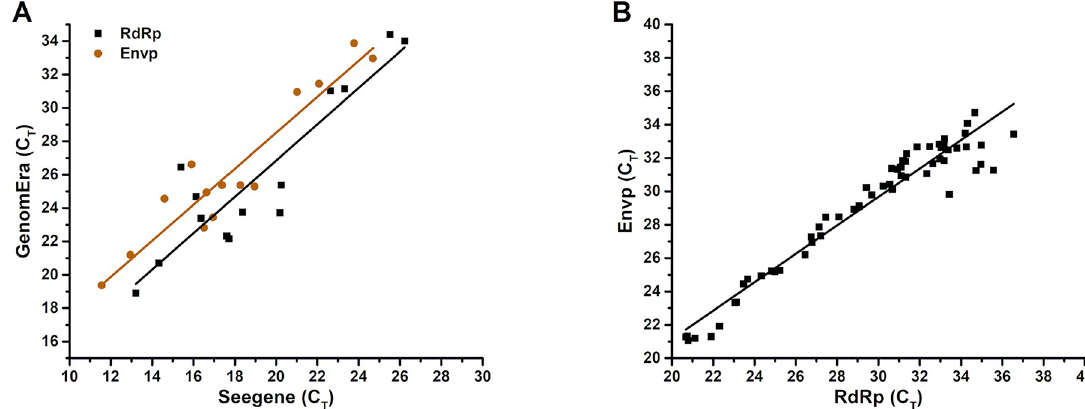
Fig 1. Linear correlations between the C T values obtained using Seegene Allplex 2019-nCoV and GenomEra SARS-CoV-2 assays. (A) Fourteen positive samples were assayed using Seegene Allplex 2019-nCoV and GenomEra SARS-CoV-2 assays at Site 1, and the results were compared. Linear correlations were 0.91 and 0.94 for RdRp and Envp, respectively. (B) A linear correlation of 0.97 comparing RdRp and Envp was derived from 63 assay runs from 43 unique samples and 20 dual-runs using GenomEra SARS-CoV-2